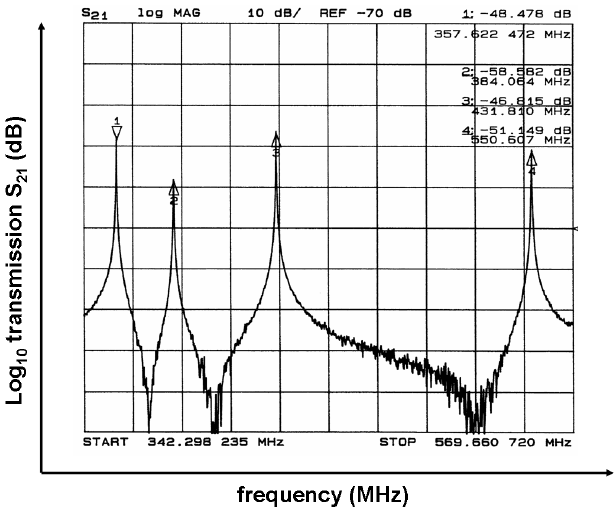
FIG. 19. The first low level rf measurement at room tempera- ture shows the mode spectrum between 340 and 570 MHz. The ordinate scale is 10 dB = division, the frequency is swept between 342 and 570 MHz.